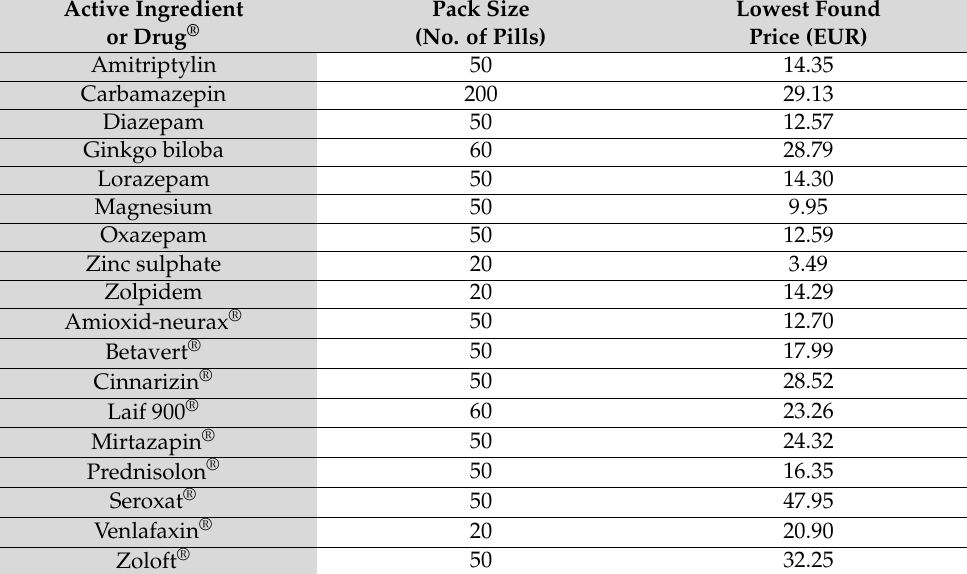
Table 4. Costs of prescribed